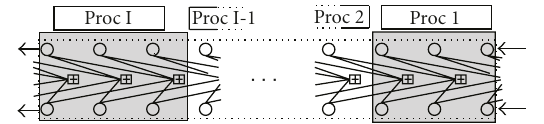
Figure 3: The LDPC-CC decoder sliding window represented as a series of processors.